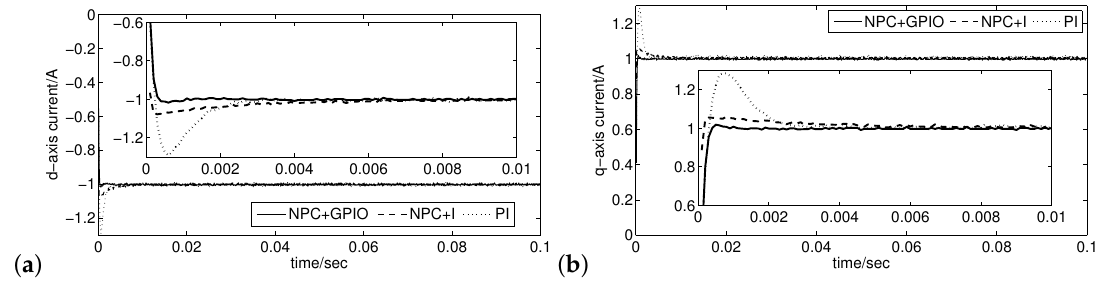
Figure 6. D- and q-axes current step response curves (the reference d-axis current is − 1 A and the reference q-axis current is 1 A) in the case of model parameters variations under the proposed controller (NPC + GPIO), the integral controller (NPC + I) and the improved PI controller: ( a ) d-axis; ( b ) q-axis. Table 3. Comparison of current-tracking performance indices in the case of nominal model.